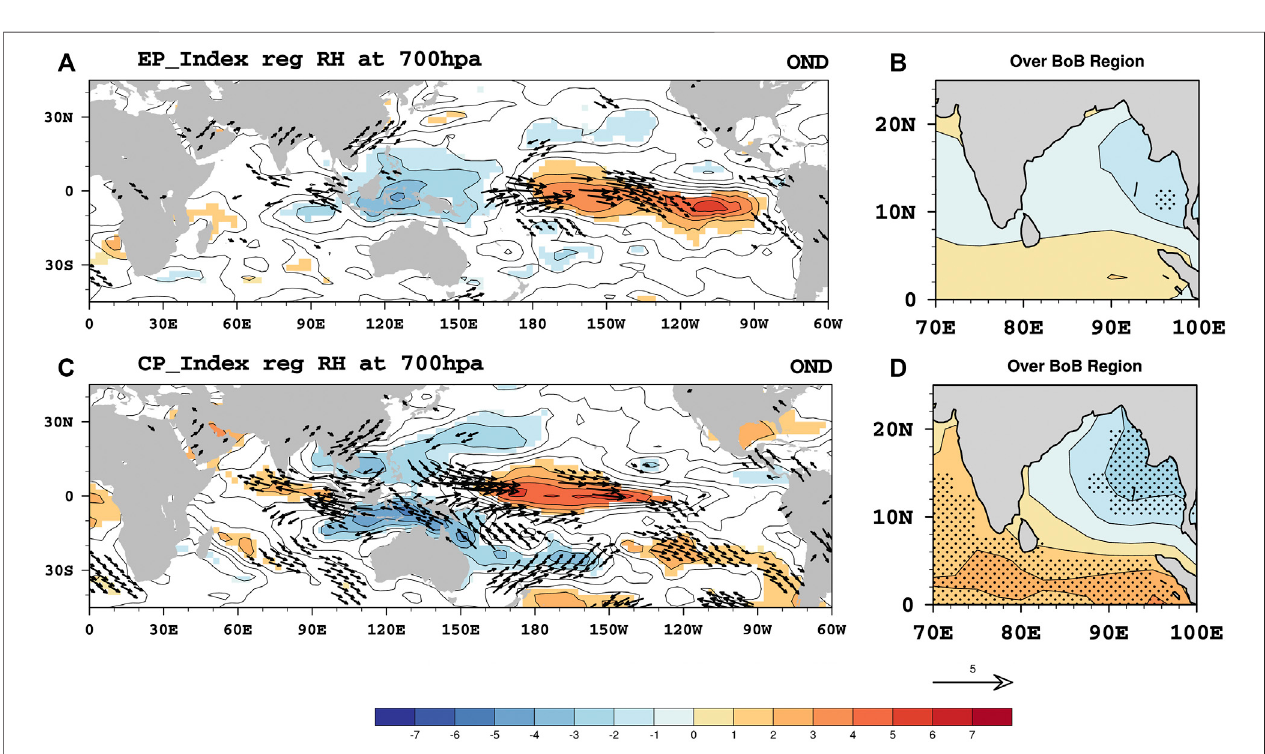
FIGURE 10| Regressed relativehumidity (RH) at 700 hPa and wind at 850 hPa in OND with the EPindex (A) at global scale, and (B) over the BoB. (C,D) Sameas theupperpanelbutfortheCPindex. Thered (blue)shadingindicatespositive(negative)signi fi canceatthe95%level.Vectors arestatisticallysigni fi cantatthe95%level.